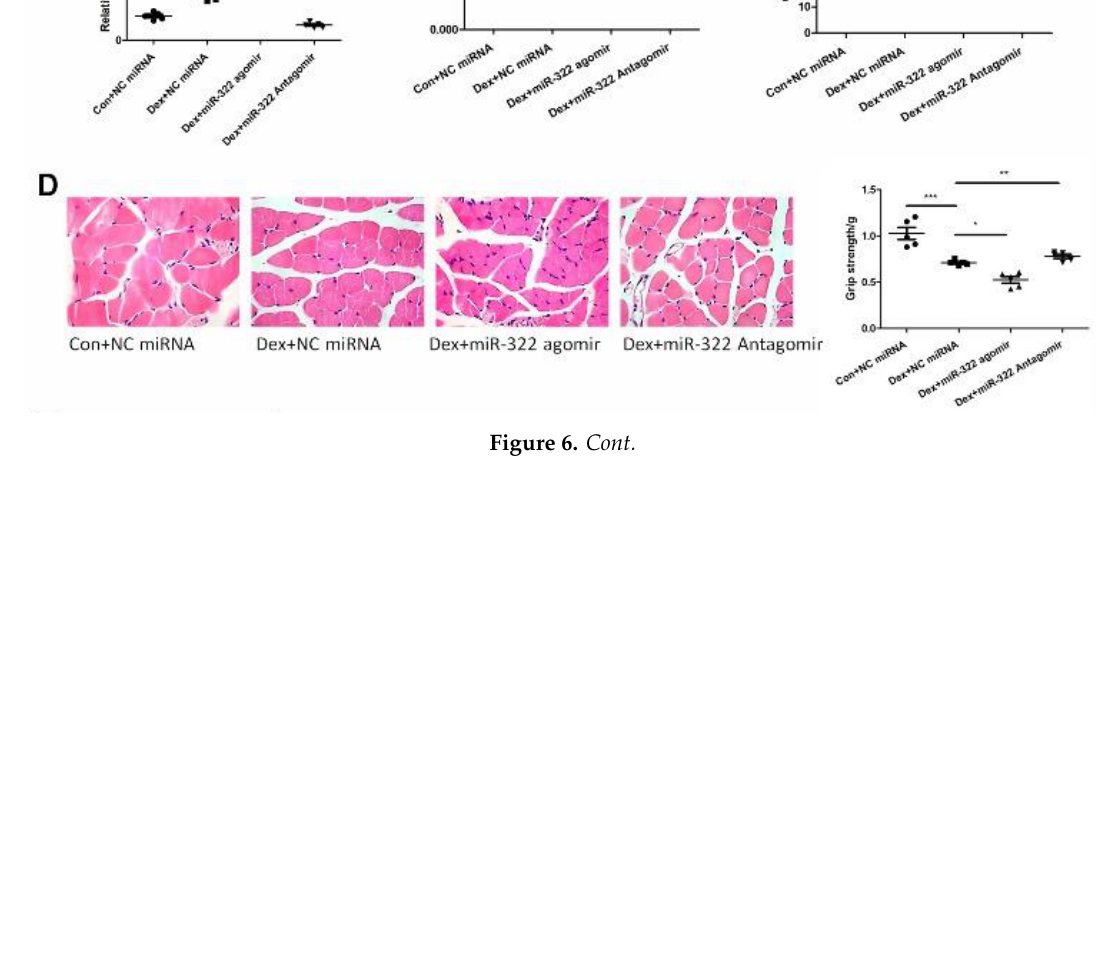
Figure 6. miR-322 aggravated Dex-induced muscle atrophy in vivo. ( A ) qRT-PCR analysis showed the expression of miR-322 ( B ) Gastrocnemius weight/body weight (GW/BW) ratio in mice was showed. ( C ) Grip strength of the right hind limb was showed. ( D ) HE staining (400×) showed muscle fiber diameter in mice. ( E ) qRT-PCR analysis showed Atrogin-1 and MuRF-1 expression levels in mice. ( F ) Western blot analysis showed increased expression of IGF1R and INSR in vivo. Scale bar, 10 µm. NC, negative control. Dex, dexamethasone. * p < 0.05, ** p < 0.01 and *** p < 0.001. 3. Discussion Dex has been considered an effective agent to induce muscle atrophy in vitro or in vivo given its potential to stimulate protein catabolism [26]. This property might result from multiple mechanisms, including the inhibition of amino acid transport (leucine in particular), disrupted protein synthesis by inhibition of the activities of insulin and IGF1 , and inhibition of myogenesis through myogenin downregulation [8]. Recent studies demonstrated that microRNAs play key roles in skeletal muscle atrophy [27,28]. miRNAs participate in multiple regulatory pathways in the skeletal muscle [29]. Accumulating evidence suggests that the aberrant expression levels of miRNAs, such as miR-1, miR- 133, miR-23a, miR-206, miR-27, miR-628, miR-431, and miR-21 [20,21,30–34], contribute to muscle atrophy in a variety of animal models. In this study, we noted that miR-322 elevated and aggravated